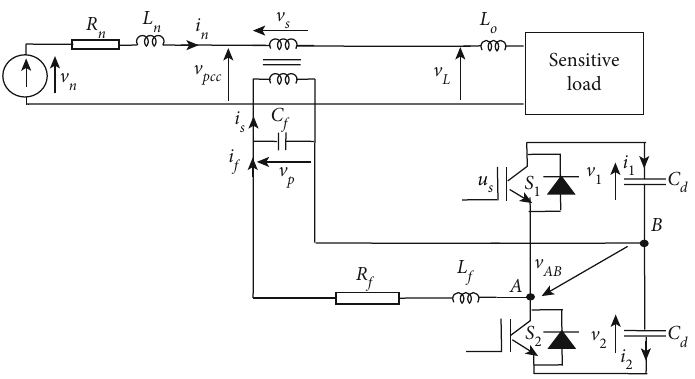
Figure 1: Single-phase half-bridge series active power fi lter operating with a sensitive